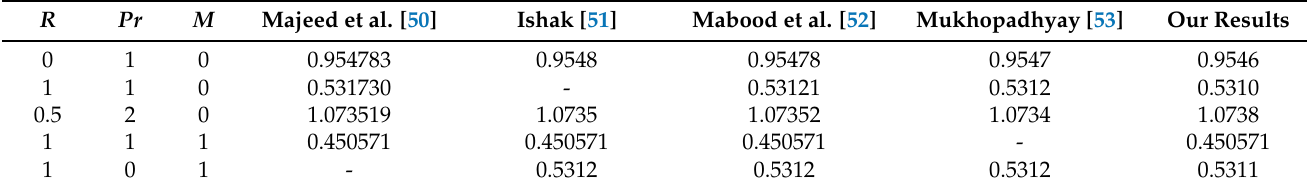
Table 4. Comparison of R , Pr and M .